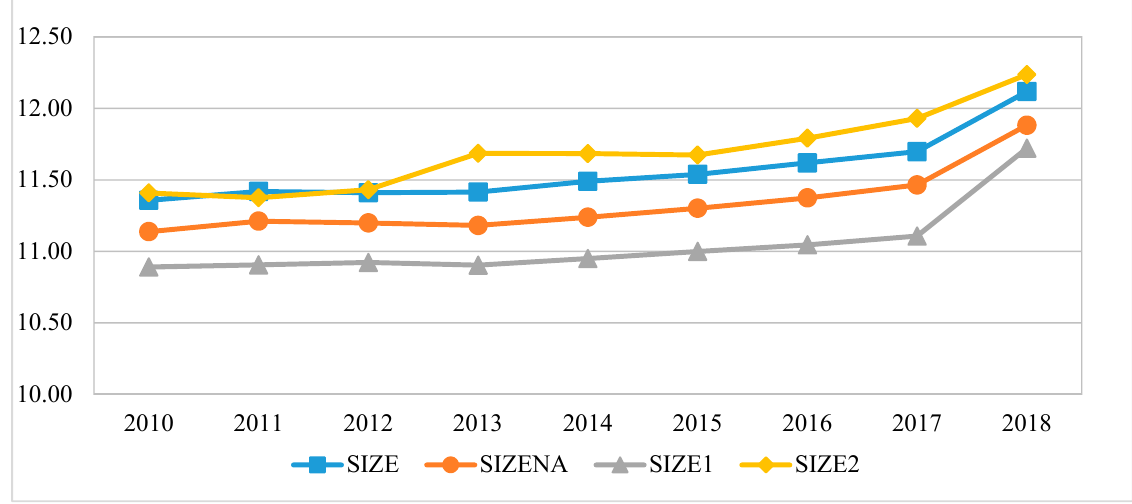
Figure A1. The trends of firm size measures (in logarithm terms). Note: This figure provides the time series of the average firm size measures in logarithm terms for all the firms in the sample data.